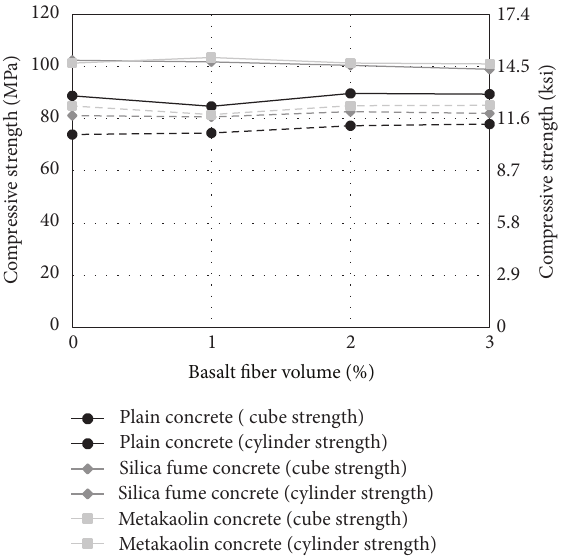
Figure 5: Average cube and cylinder compressive strength.